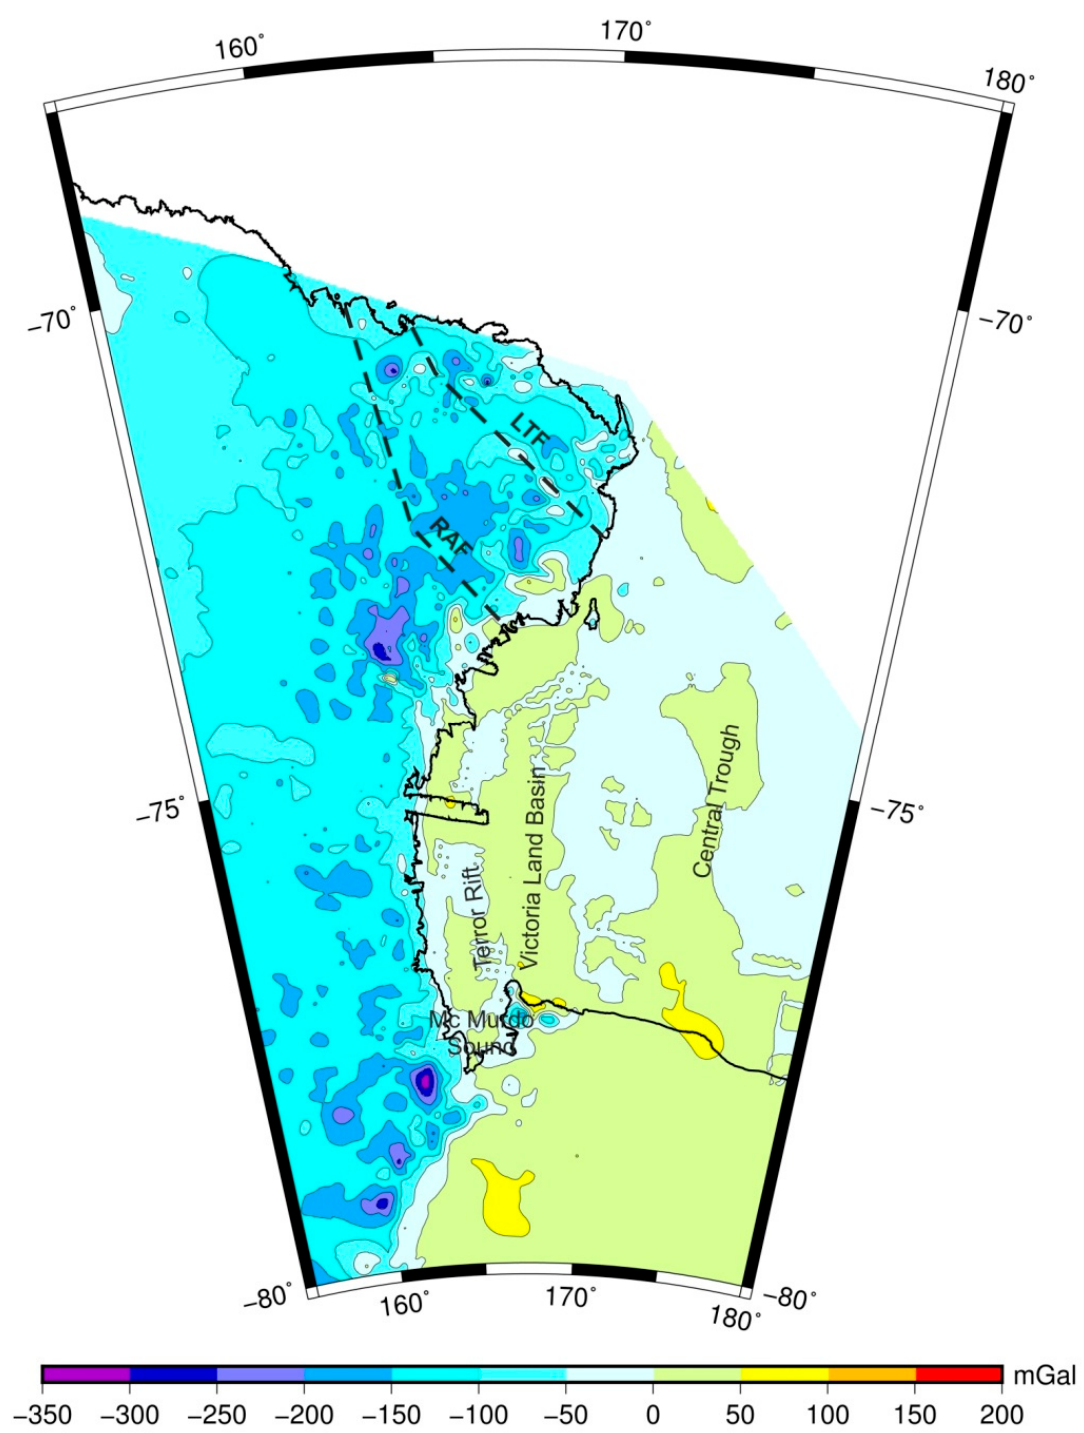
Figure 10. Gridded data of Bouguer Gravity (BG) anomalies (mGal) in Victoria Land (contour interval at 50 mGal).